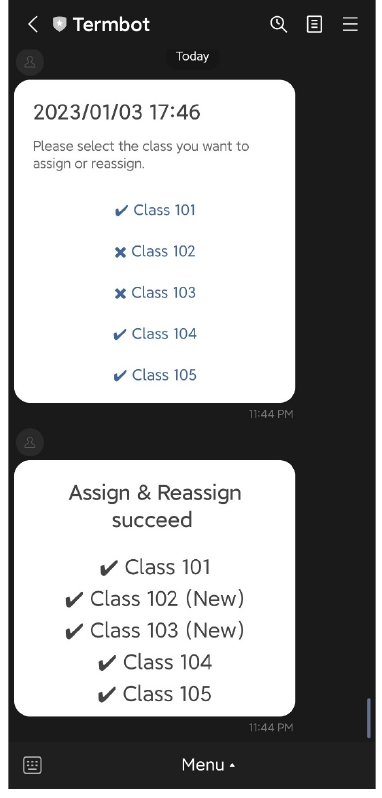
Figure 10. When the function “Assign & Reassign” ends.